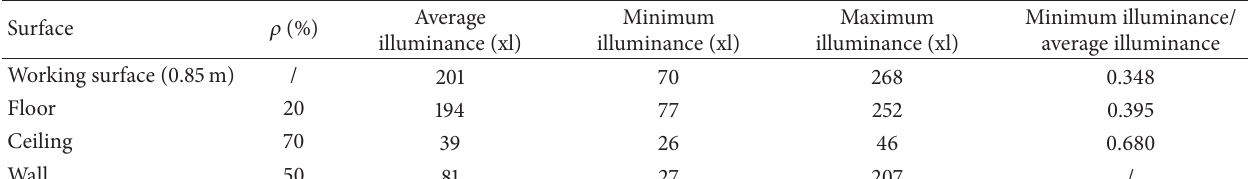
Table 2: The illuminance value of natural light guidance systems in the visitor centre.